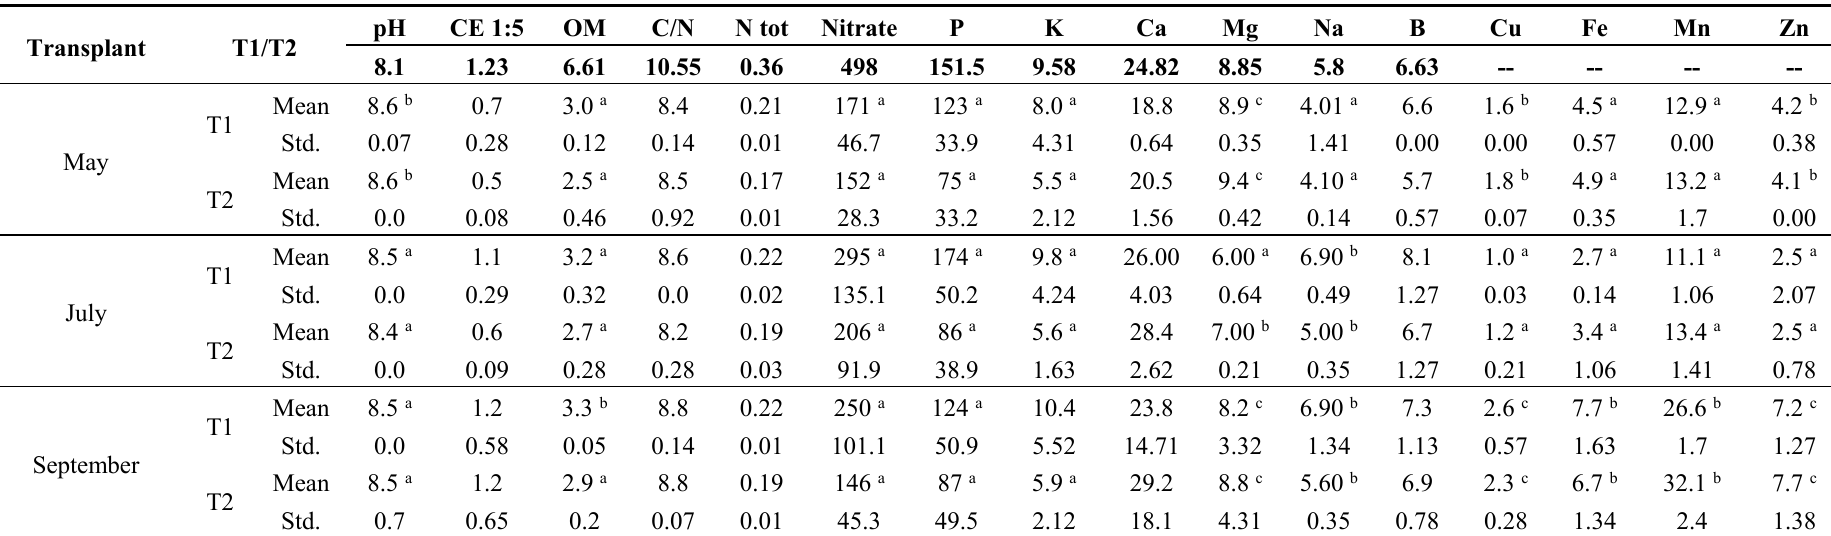
Table 1. Determination of organic matter (OM, expressed in %), total nitrogen (N tot, expressed in %), electrical conductivity 1:5 (EC, dS/m), nitrate (expressed in mg·kg −1 , available phosphorus (P, expressed in mg·kg −1 ), extracted cations (expressed as me 100 g −1 ): potassium (K), calcium (Ca), magnesium (Mg), sodium (Na), and the rest of analyzed nutrients (expressed in mg∙kg −1 ): boron (B), copper (Cu), iron (Fe), manganese (Mn) and zinc (Zn), for T1 and T2, expressed by mean and standard deviation. Transplant T1/T2